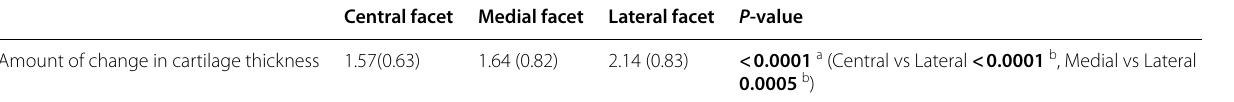
Data are reported as the mean (standard deviation), unless otherwise indicated. Bolded P-values indicate statistical significance ( P < .05) Significance levels with Student’s t -test